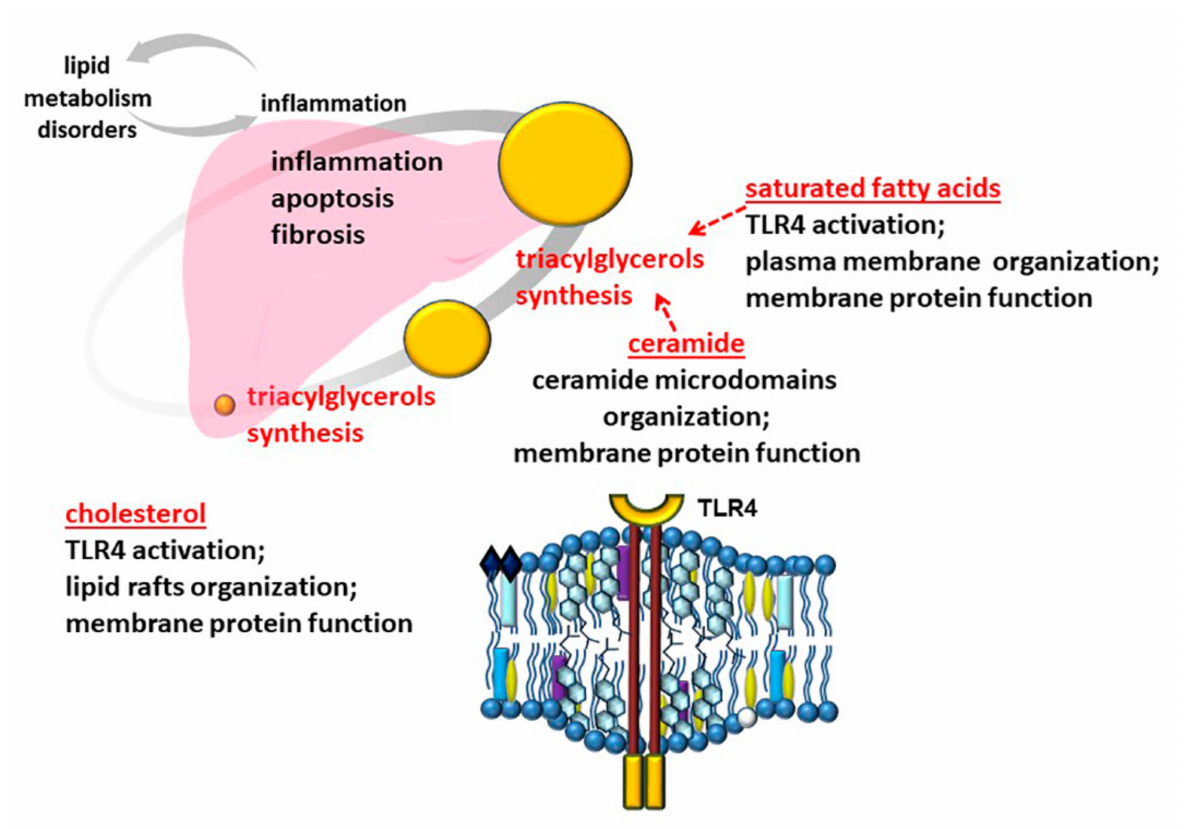
Figure 2. The scheme of lipid participation in the mechanisms of NAFLD development. Ceramides, cholesterol, and SFA demonstrate a link to inflammation through the regulation of cell plasma membrane structure and function and are involved in TAG formation and liver